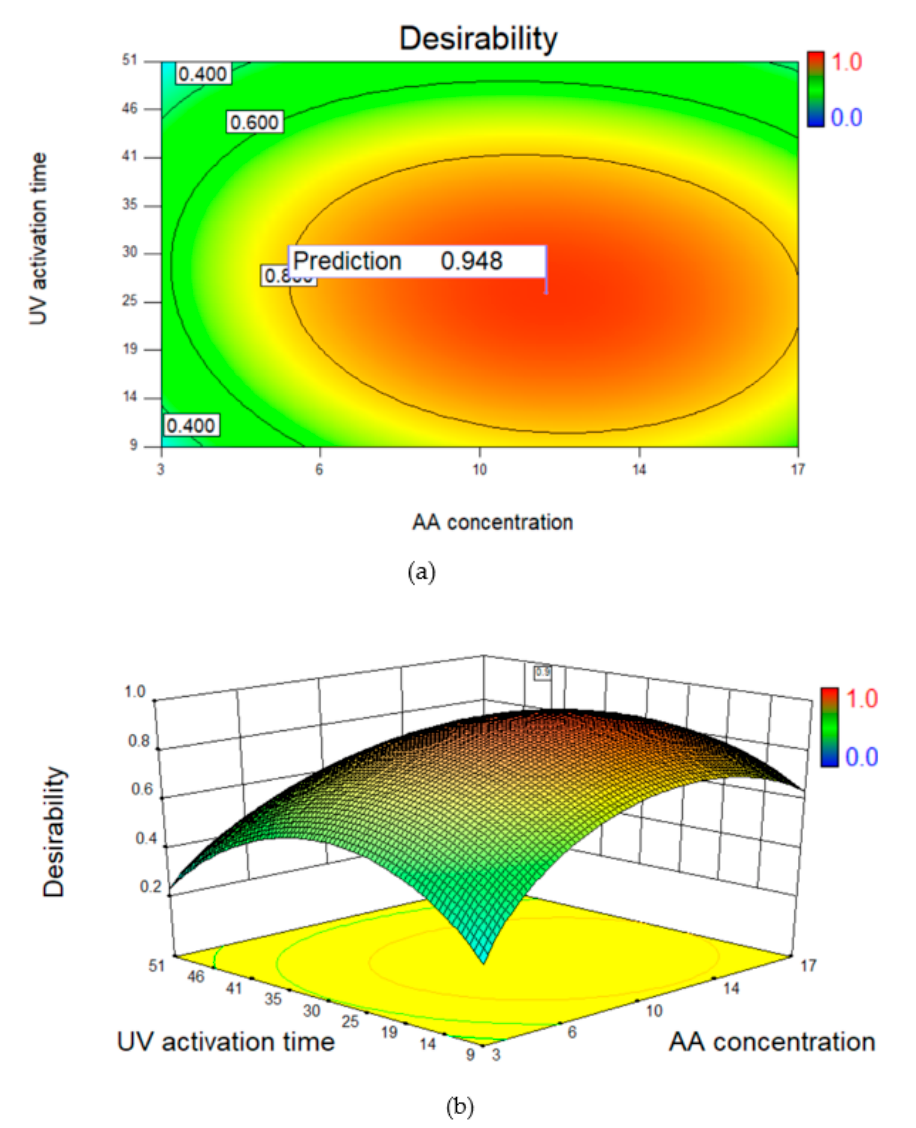
Table 8. Predicted and experimental responses at optimum conditions.